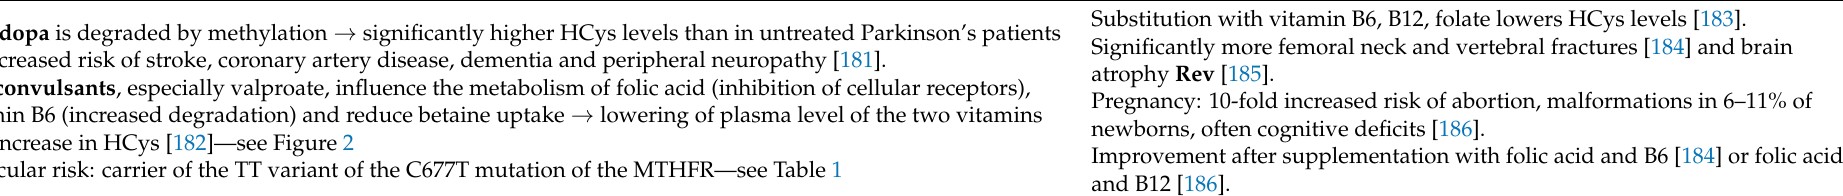
Table A6. Pharmacotherapy of neurodegenerative diseases: Parkinson’s disease, epilepsy.